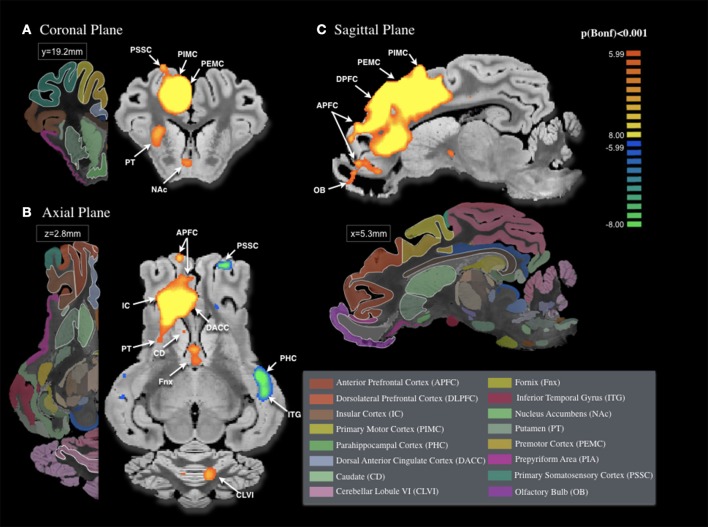
Areas of activation with unilateral ventral tegmental area (VTA) stimulation (3 V, 250 μs, 130 Hz, n = 4). Areas of significant BOLD change in the (A) Coronal Plane, (B) Axial Plane, and (C) Sagittal Plan included cortical structures [anterior prefrontal cortex APFC, dorsolateral prefrontal cortex DLPFC, primary motor cortex PIMC, dorsal anterior cingulate cortex DACC, premotor cortex PEMC, and primary somatosensory cortex PSSC, insular cortex IC, and parahippocampal cortex PHC (contralateral)], subcortical structures [caudate CD, fornix Fnx, inferior temporal gyrus ITG (contralateral), nucleus accumbens NAc, putamen PT, prepyriform area PIA, olfactory bulb OB and cerebellar lobule VI CLVI (contralateral). All areas of activation deemed significant were Bonferroni-corrected, p < 0.001]. 3D pig brain atlas template used from Saikali et al. (2010).